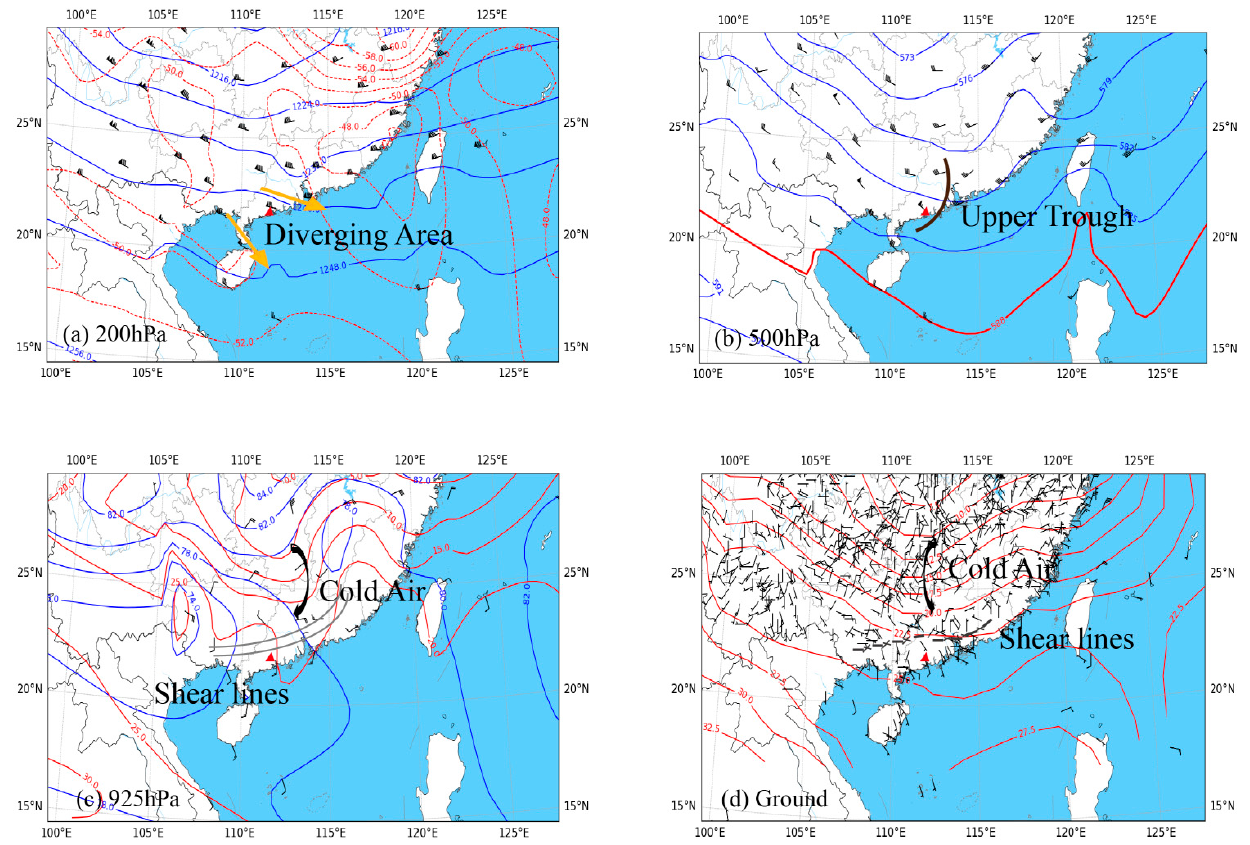
Figure 2. Circulation patterns at 20:00 LST on 27 March 2020 (revealed by MICAPS data). ( a ) 200 hPa; ( b ) 500 hPa; ( c ) 925 hPa; ( d ) ground. Provincial borders are indicated by solid grey lines; land and sea are marked in white and blue, respectively. The study area is marked with a red triangle. In ( a – c ), the solid blue lines (black arrows) represent geopotential height (winds), while the shaded colors represent the wind speed, the long line represents 4 m·s − 1 , the short line represents 2 m·s − 1 , and a flag represents 20 m·s − 1 . The red lines in ( a , c , d ) indicate temperature. In ( b ), the red lines represent the geopotential height of 588 gpm.